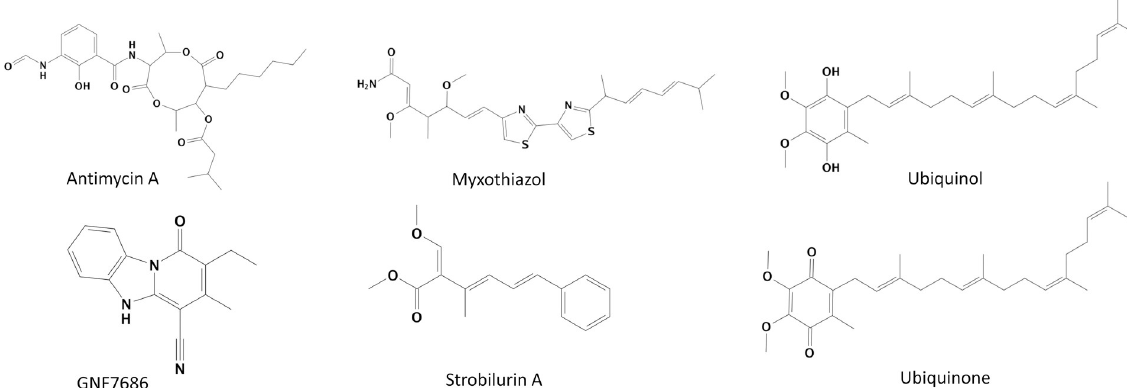
Fig 2. Chemical structures of Qi inhibitors (left), Qo inhibitors (middle), and substrates (right).